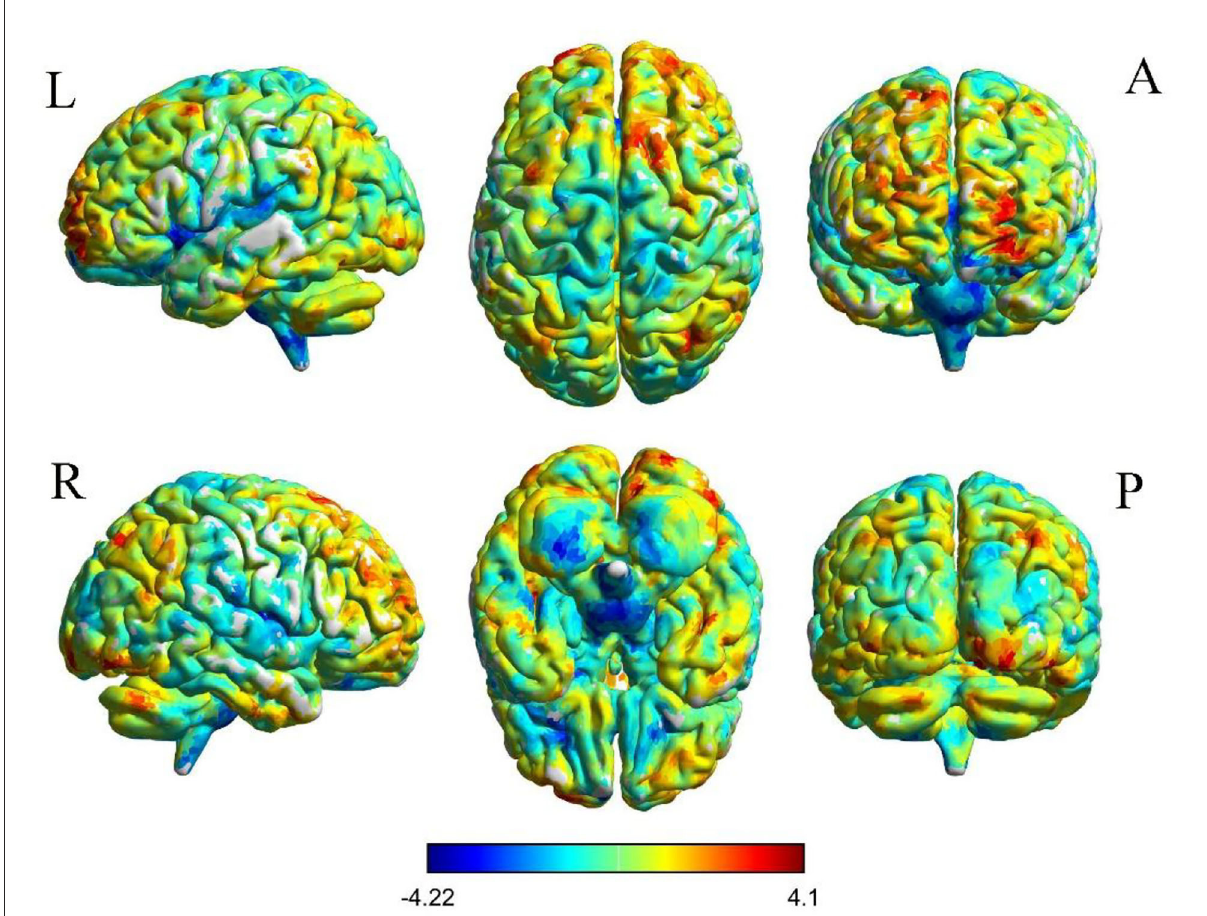
FIGURE2 Voxelwise comparison of FC between participants in the PACG and HC groups based on the left thalamus seed (voxel-level P < 0.05, AlphaSim corrected). Color bars indicate t-scores; warm colors indicate areas where the FC value in PACG is greater than that in HCs, while cold colors indicate the